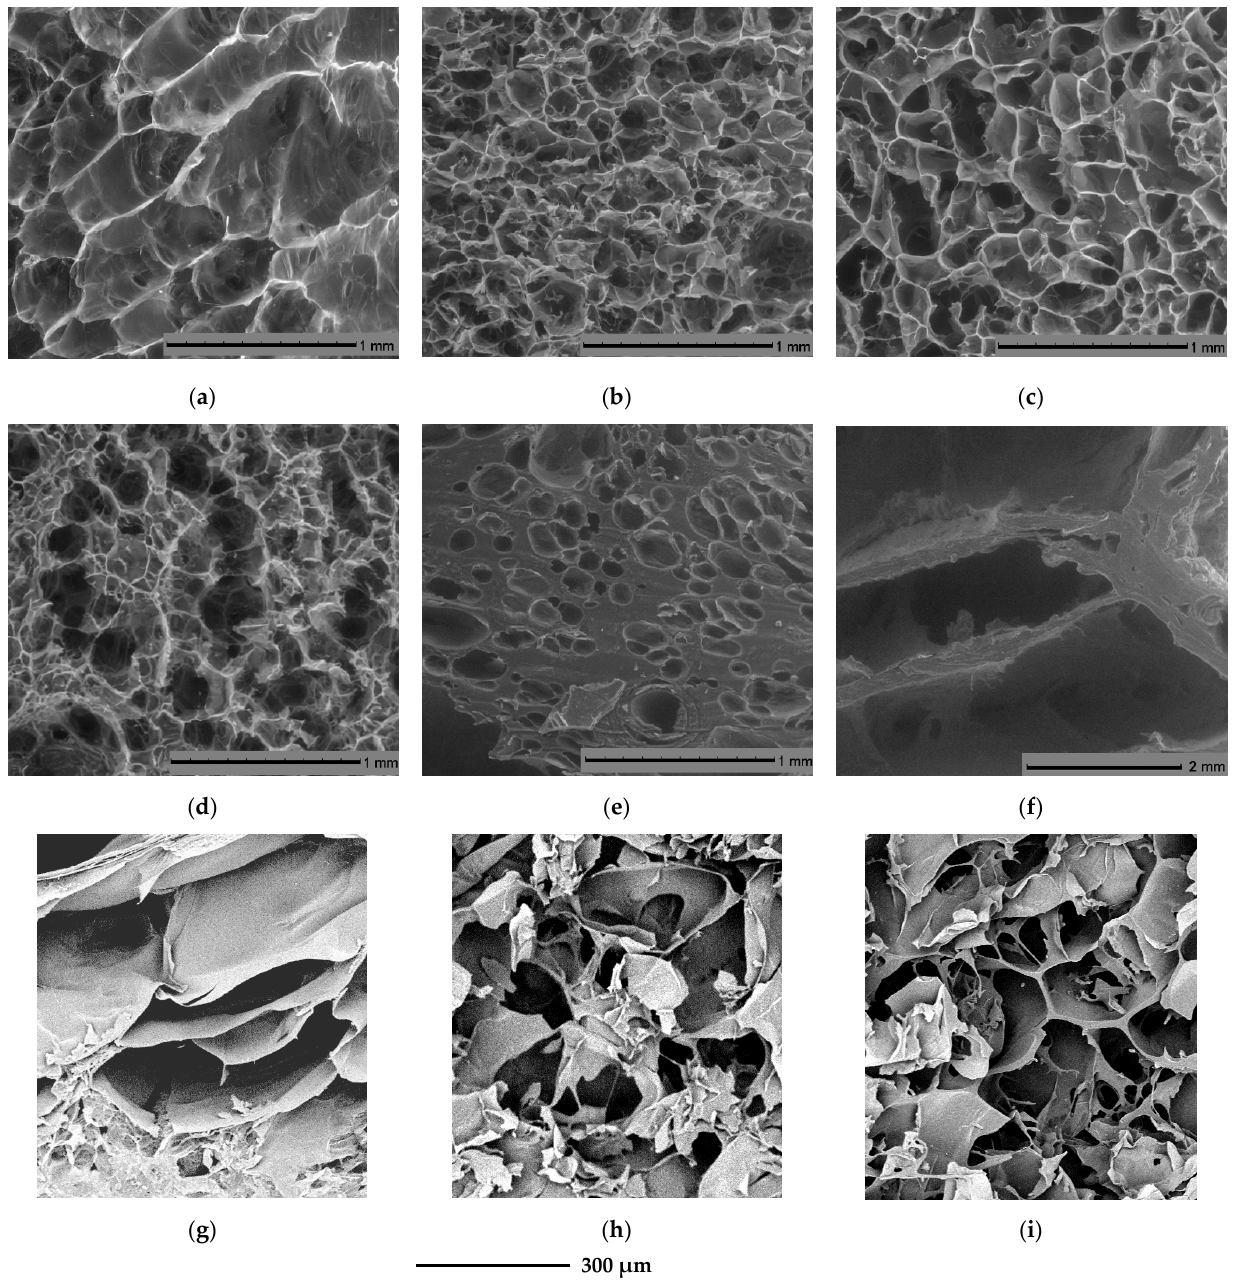
Figure 4. SEM views of different freeze-dried gels; ( a , g ) FD-P0%; ( b , h ) FD-P25%; ( c , i )-FD- P40%DE; ( d )-FD-P40%DE-MC; ( e )-AD-P40%DE-MC; ( f ) VD-P40%DE-MC.